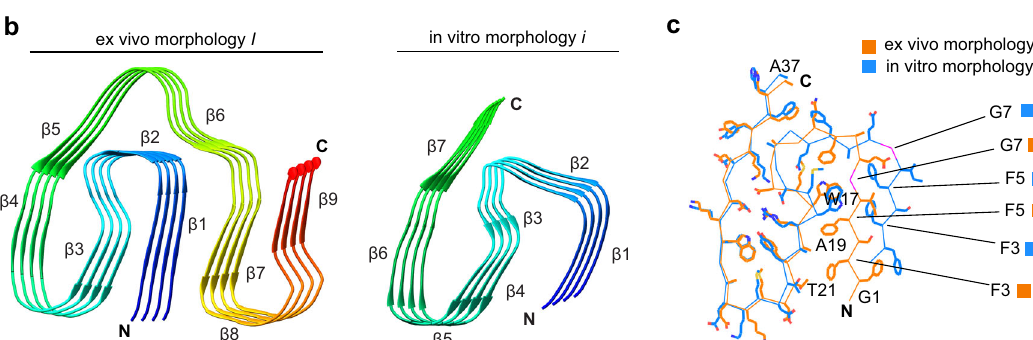
Fig. 3 Fibril protein conformation in in vitro and ex vivo fi brils. a Sequence of SAA1.1 indicating the location of the β -strands. b Ribbon diagrams of fi bril protein stacks (ex vivo fi bril morphology I and in vitro fi bril morphology i) colored in rainbow palette. c Alignment of residues 1 – 37 of the ex vivo (orange) and in vitro fi bril protein structure